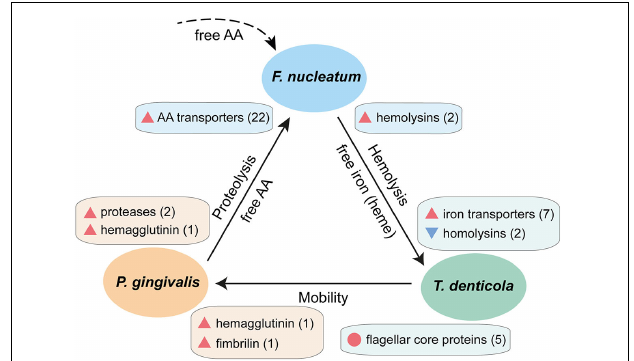
FIGURE 5 | Schematic interaction model showing synergistic pathogenicity of F. nucleatum , P. gingivalis , and T. denticola based on their transcriptional profiles in chronic periodontitis. Blue triangles denote down-regulation, red triangles up-regulation in vivo , the number in parentheses indicate the number of genes of this particular function, and the red circle denotes a set of genes which are highly expressed both in vivo and in laboratory culture. The dashed line indicates contribution of free amino acids by other members of the periodontal